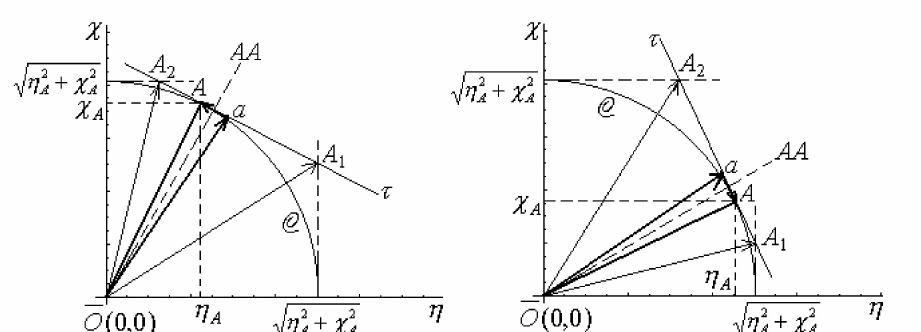
Figure 4. The same diagram as of Figure 3, yet here for treating mononuclear atoms A 1 and A 2 in covalent/molecular bonding A-A ; one notices the circular curve (C) on which both atoms-in-bonding evolve; the stabilization of the chemical reactivity is by means of the diagram-left contributing atom for the left closing contour, or to the diagram-right for the right closing contour,